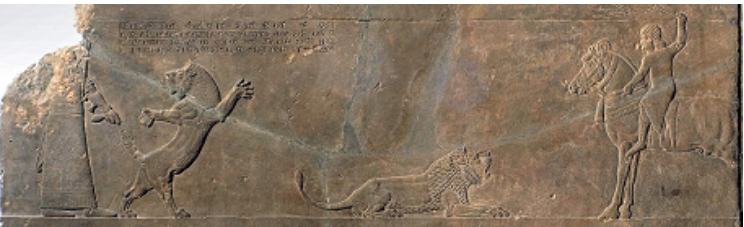
Figure 15. King Ashurbanipal grabbing lion by its tail, ready to strike (BM inv. no. 124886; reg. no. 1856,0909.51); gypsum relief; North Palace, Nineveh (mod. Iraq); Neo-Assyrian, ca. 645–635 BCE [image courtesy of the Trustees of the British Museum, London].